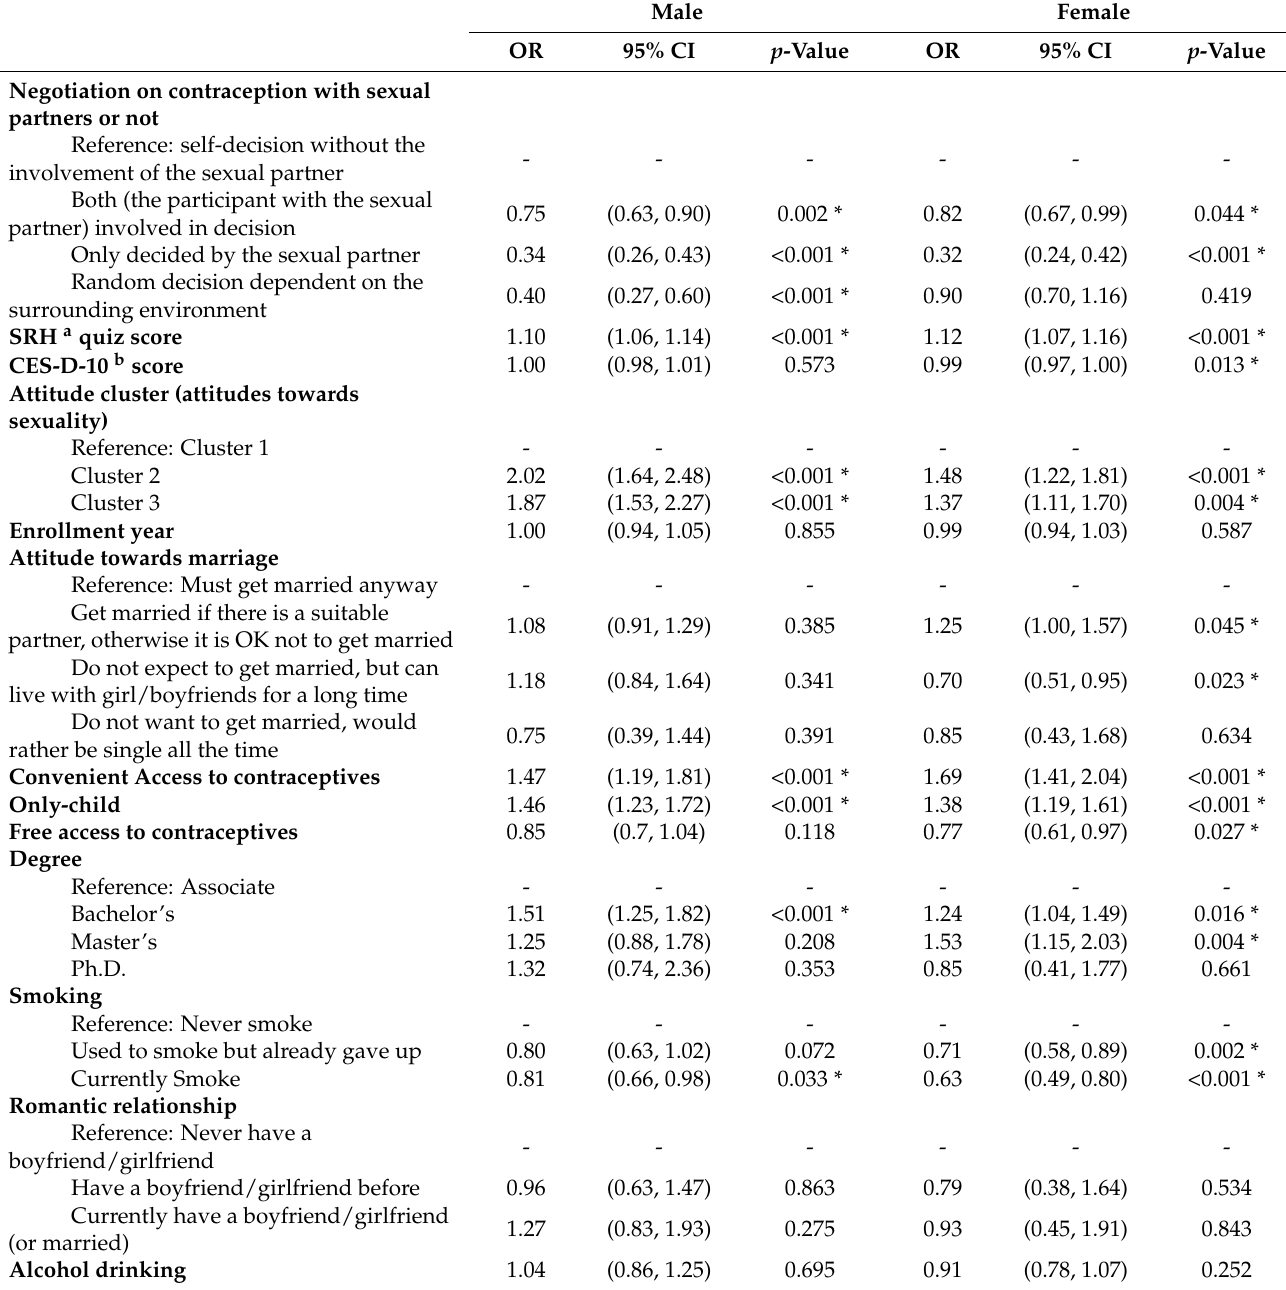
Table 2. Ordinal logistic regression to quantify the effects of the identified determinants on the frequency of contraceptive use